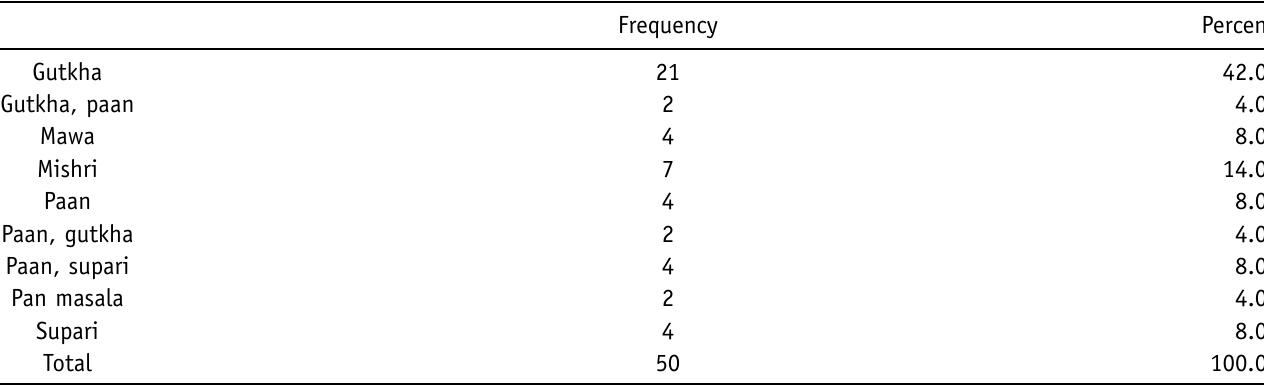
Table III. Diagram 2 - Distribution as per type of